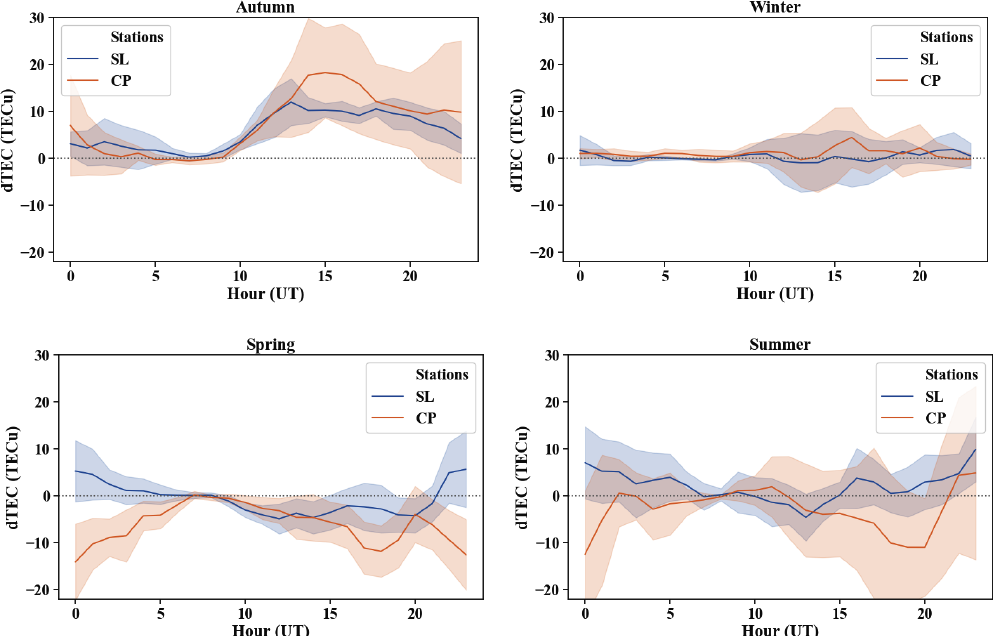
Figure 4. Seasonal dTEC response to HILDCAA intervals. The blue and coral lines refer to São Luís and Cachoeira Paulista,